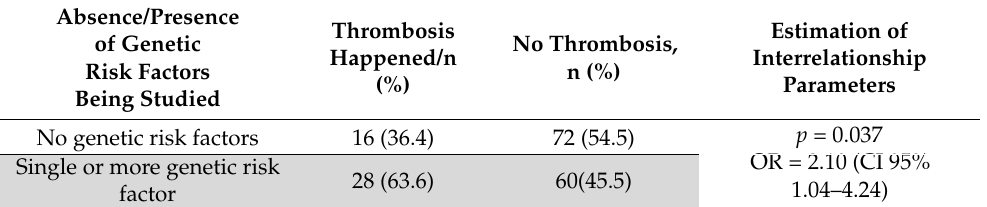
Table 5. Prevalence of thrombosis events in COVID-19 patients having at least one genetic throm- bophilia marker and without markers.